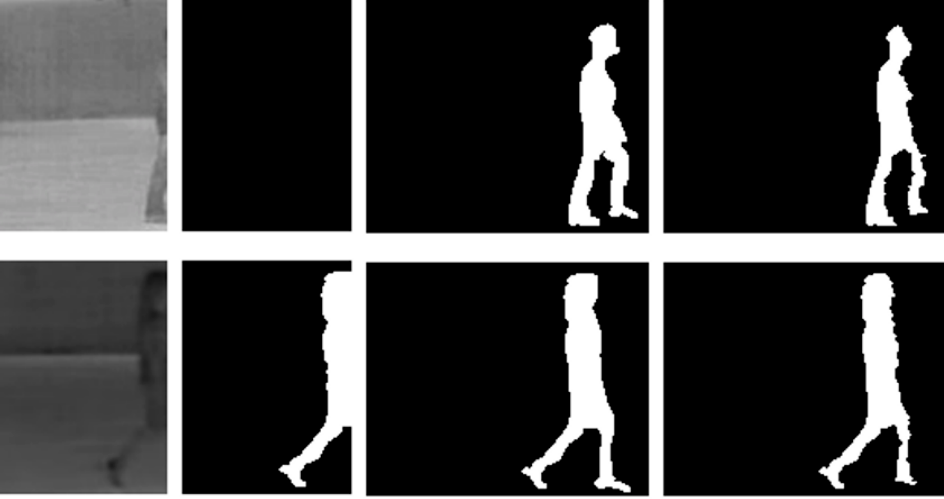
Figure 21. Example images by human segmentation from fold-2: ( a ) original images; segmentation results using ( b ) original images and ( c ) GT images; and the images predicted by ( d ) the proposed method. 4.5. Processing Time The processing times of the proposed image prediction method and the human seg- mentation method are shown in Table 16. Each component of the proposed method (as shown in Figure 2b) is shown in Table 16 as well. The processing time was measured in the environments described in Section 3.5. Table 16. Processing time of the proposed method per image (unit: ms). Methods